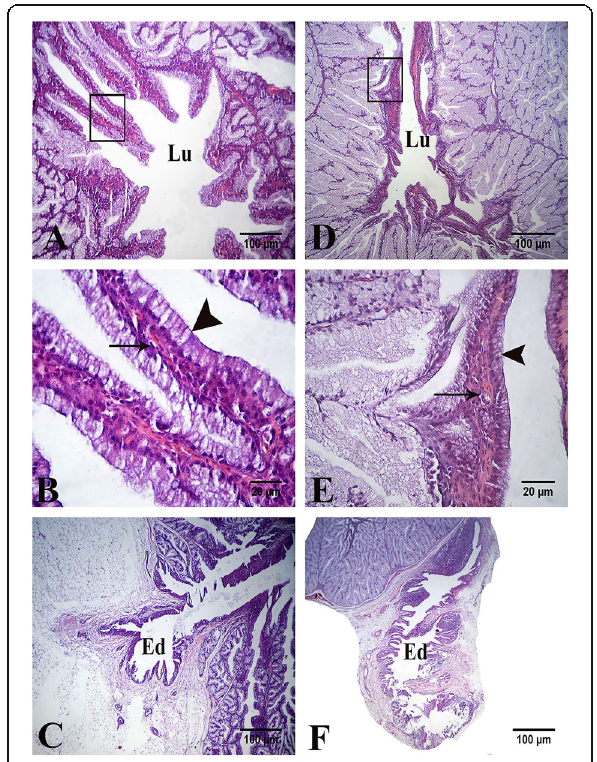
Fig. 9 Light micrograph of the HG of duck ( A , B , C ) and goose ( D , E , F ). The intratubular villi-like folds project into the lumen (Lu) of centrally situated canal ( A ). The higher magnification to the rectangle of A represents the lining epithelium of central duct was simple columnar epithelium (arrow head) and surrounded by myoepithelial cells (arrow) ( B ) and the excretory duct (Ed) in C . The irregular central lumen was contained crypts ( D ). The higher magnification to the rectangle of D represents the lining epithelium of central duct was simple columnar epithelium darkly stained (arrow head) and surrounded by myoepithelial cells (arrow) in E . The excretory duct (Ed) in F . Stain, H&E